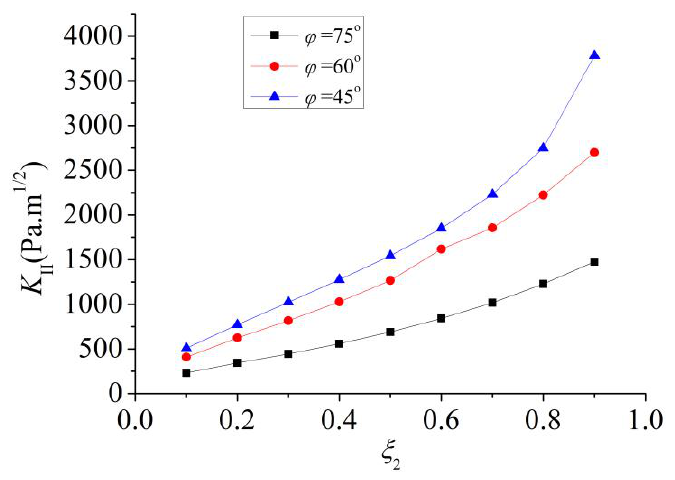
Figure 26. K II − ξ 2 for different crack inclination angles.